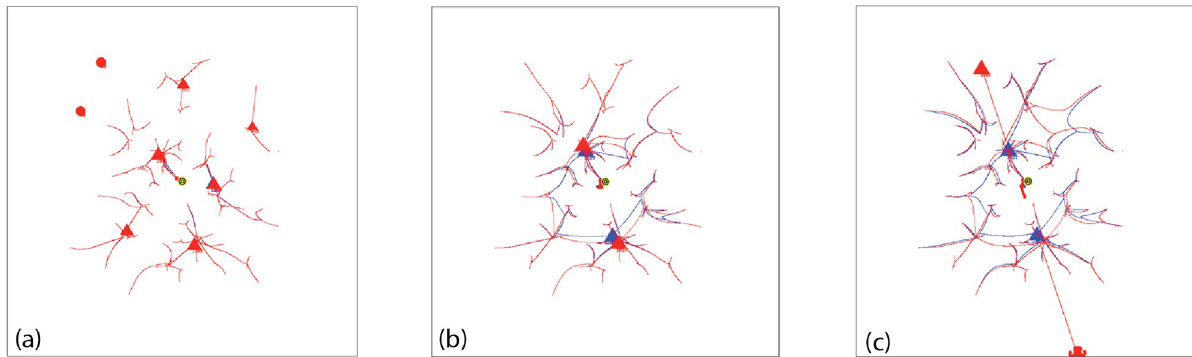
Fig 18. Overlays of simulations with (in red) and without (in blue) repulsive forces. Seed = 91, Standard Conditions. a) AIB = 30; b) AIB = 60; c) AIB = 180.